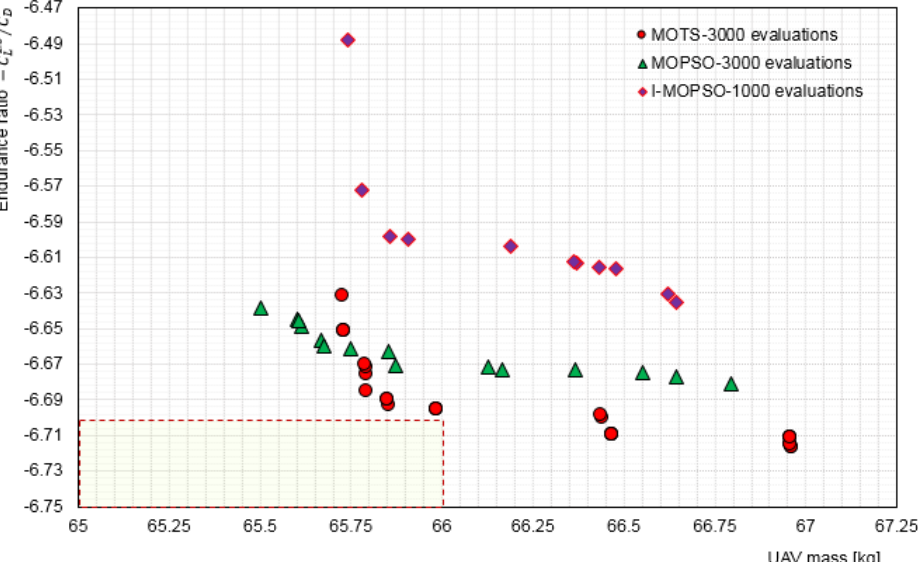
Figure 17. Comparison of Pareto front using MOTS and MOPSO for 3000 evaluations, and with I-MOPSO for 1000 evaluations.